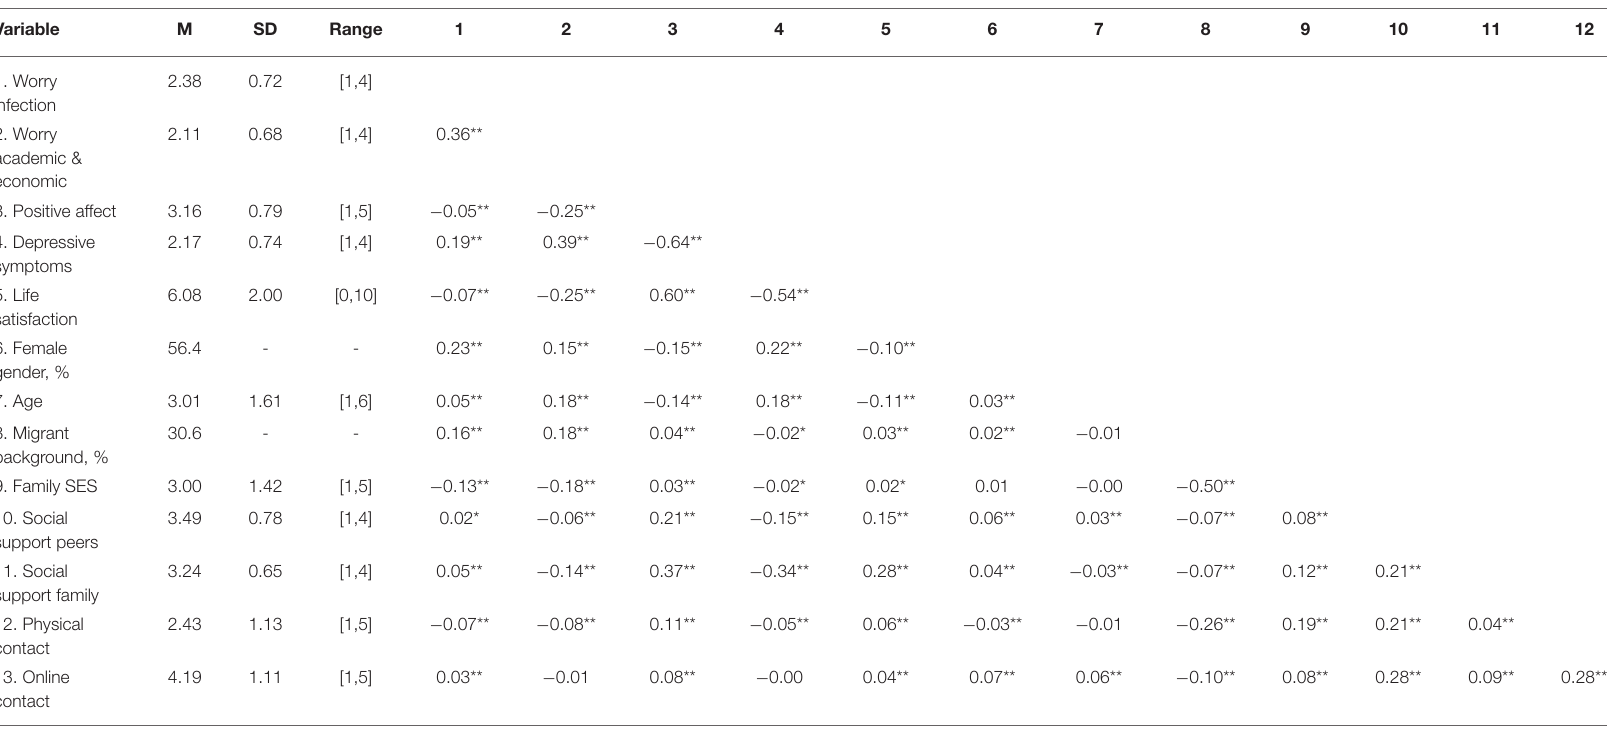
TABLE 1 | Means, standard deviations and correlations between all study variables ( N = 12,686). Variable